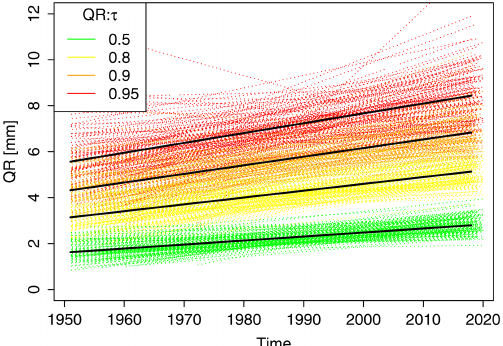
Figure 4. Quantile regression (QR in mm) on monthly maximum 5min rainfall intensities for the long series (LS) for different non- exceedance probabilities τ (shown in coloured dashed lines and in the legend). The fitted quantile regression is shown with a solid black